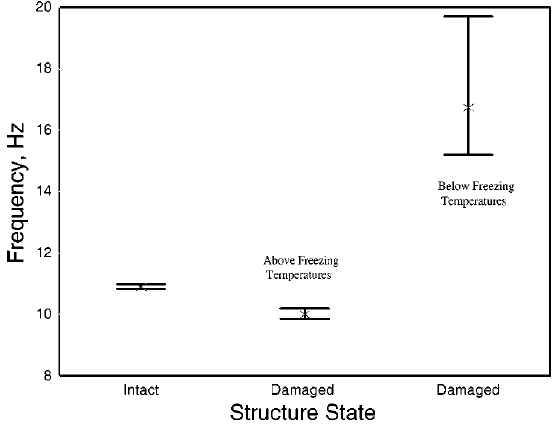
Fig. 2. Effect of in-service environment on the natural frequencies and damage